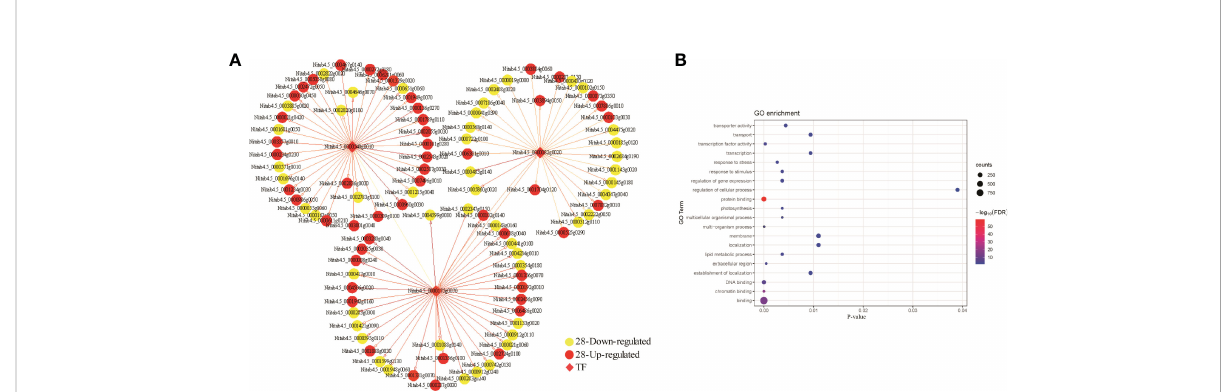
FIGURE 8 Prediction of TF regulatory networks using the co-expression correlation network of three TFs in the blue module. (A) The correlation network of genes related to regulation of the three TFs. The red representing up-regulated genes and the yellow representing down-regulated genes between M28 and K326 before and after drought treatment. The direction of the arrow indicates the regulatory relationship. The genes with weights > 0.1 are visualized by Cytoscape. (B) GO term enrichment analyses of down- and up-regulated genes related to regulation of the three